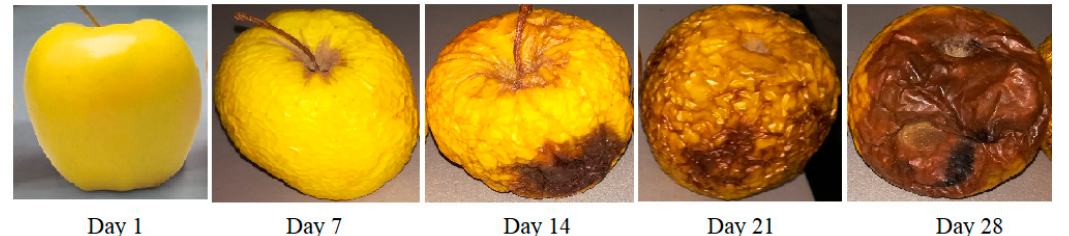
Figure 2. Pictures representing the evolution of a Golden Delicious apple over 35 days. The external appearance of apples that continues to degrade presenting speckles and wrinkles.